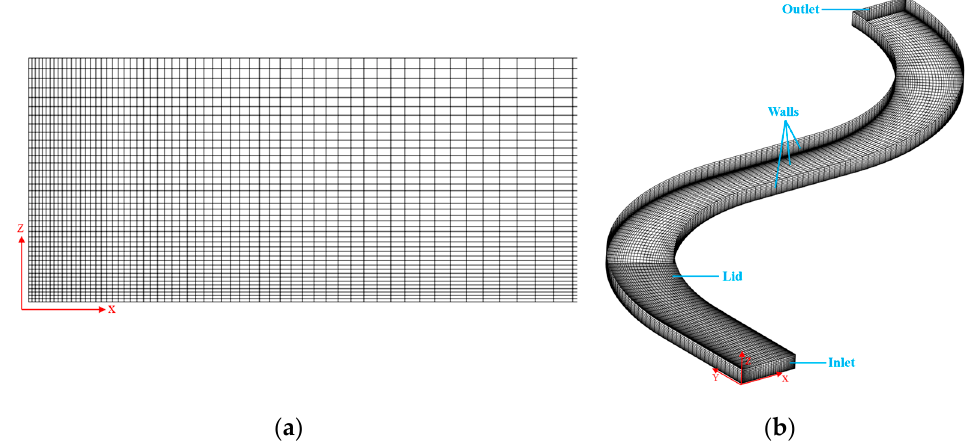
Figure 3. The sketch of mesh: ( a ) left half of cross-sectional grid line; ( b ) overview of the computa- tional domain and boundaries (every 3rd grid line is displayed). Table 2. Configurations of three sets of grids.